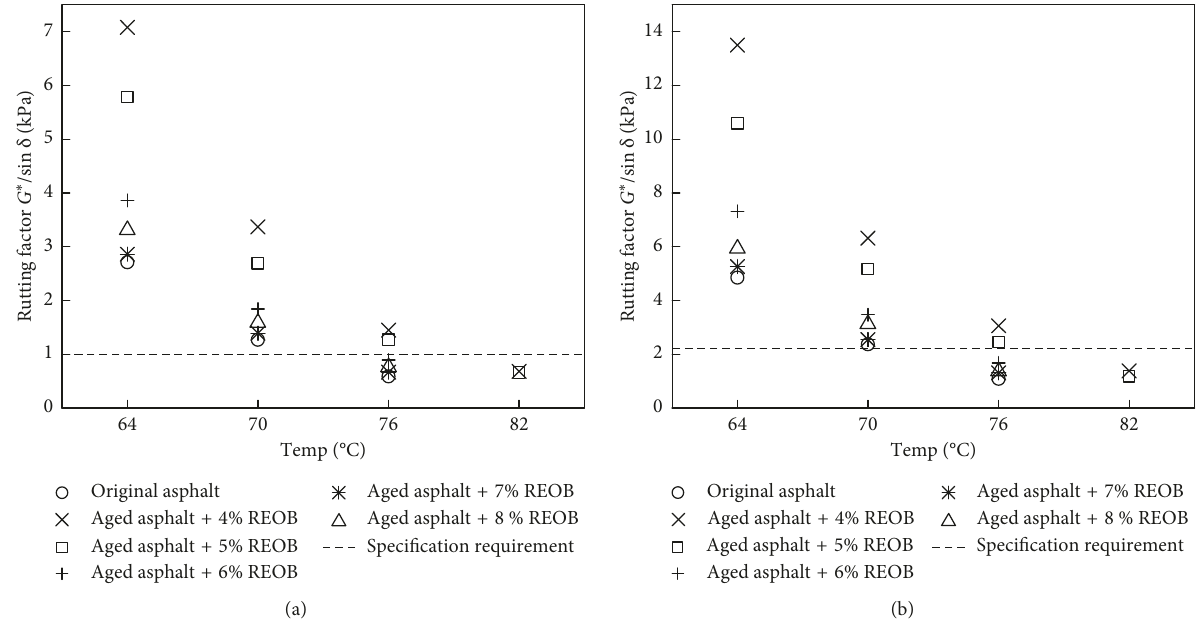
Figure 4: G ∗ /sin δ —temperature for aged asphalt with different REOB content. (a) Original. (b) After